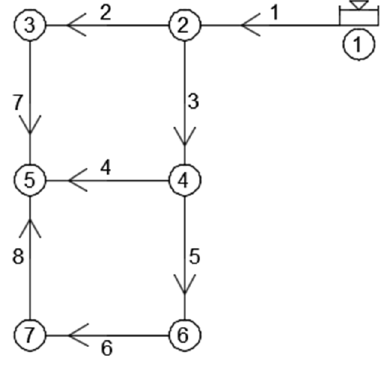
Figure 1. Layout of the two-loop network.